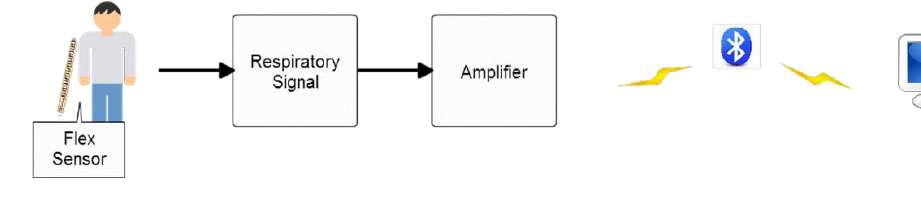
Figure 4. Process of respiratory signal sensing.